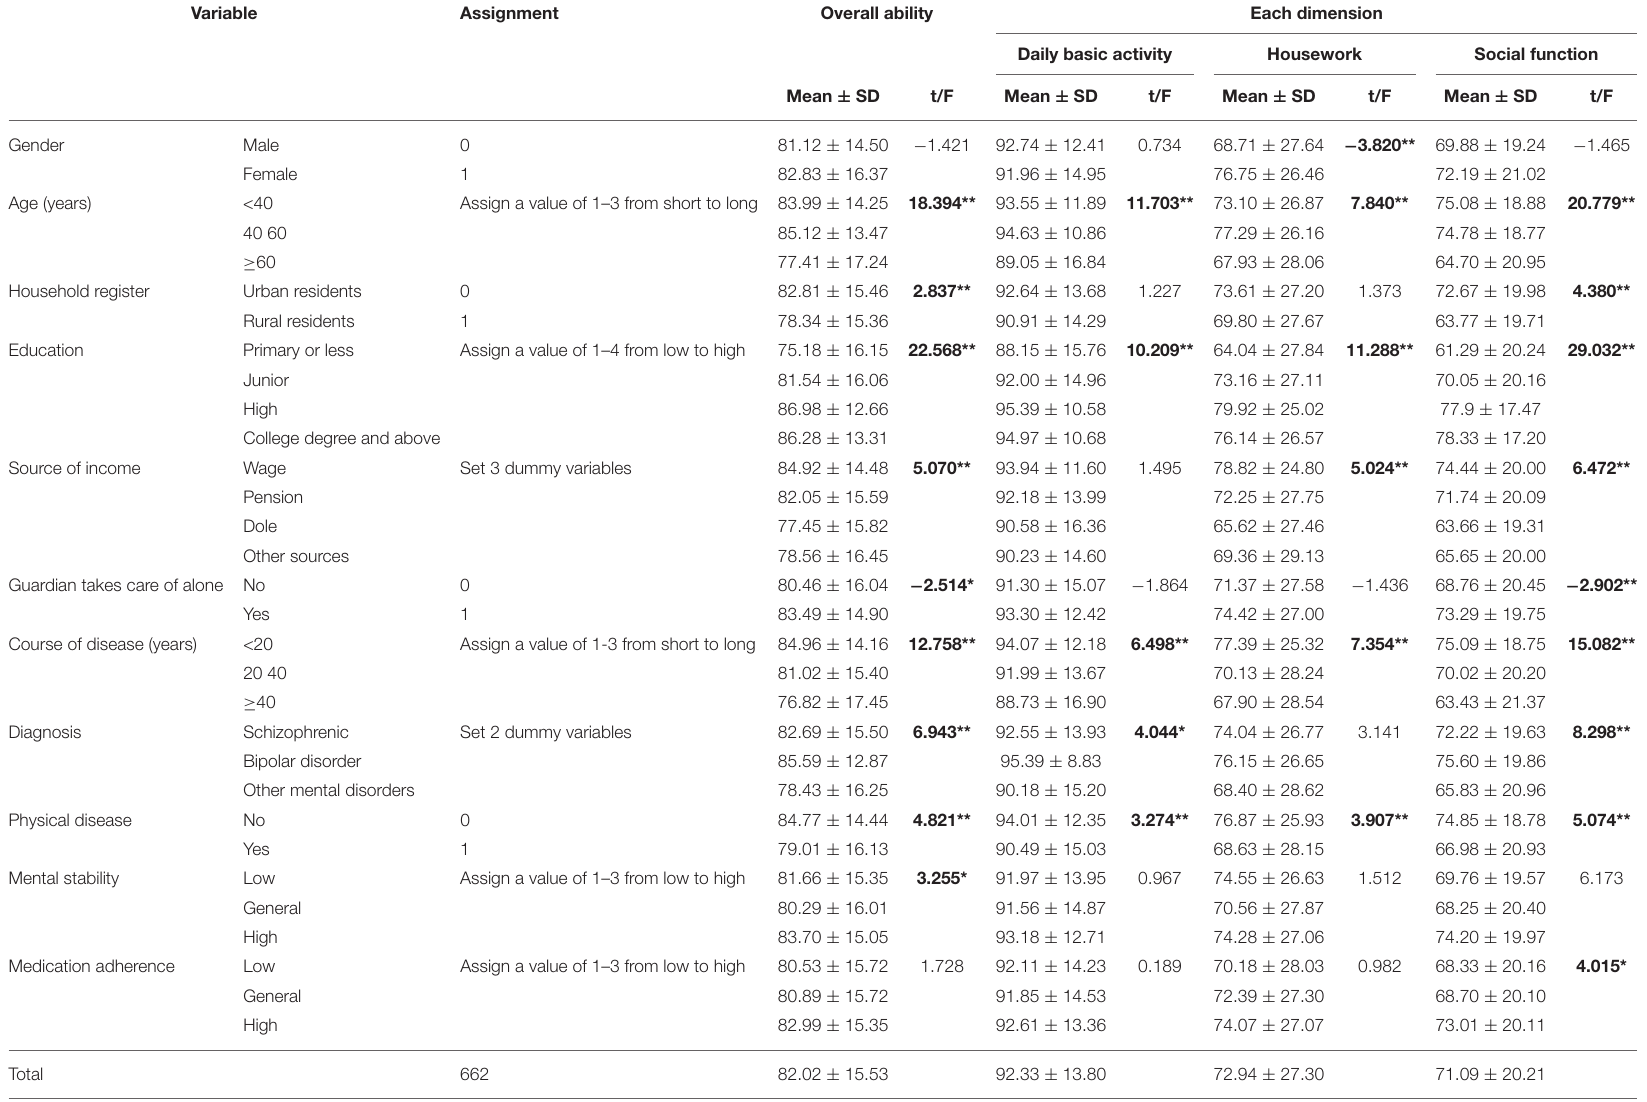
TABLE 2 | Variables assignments and univariate analysis